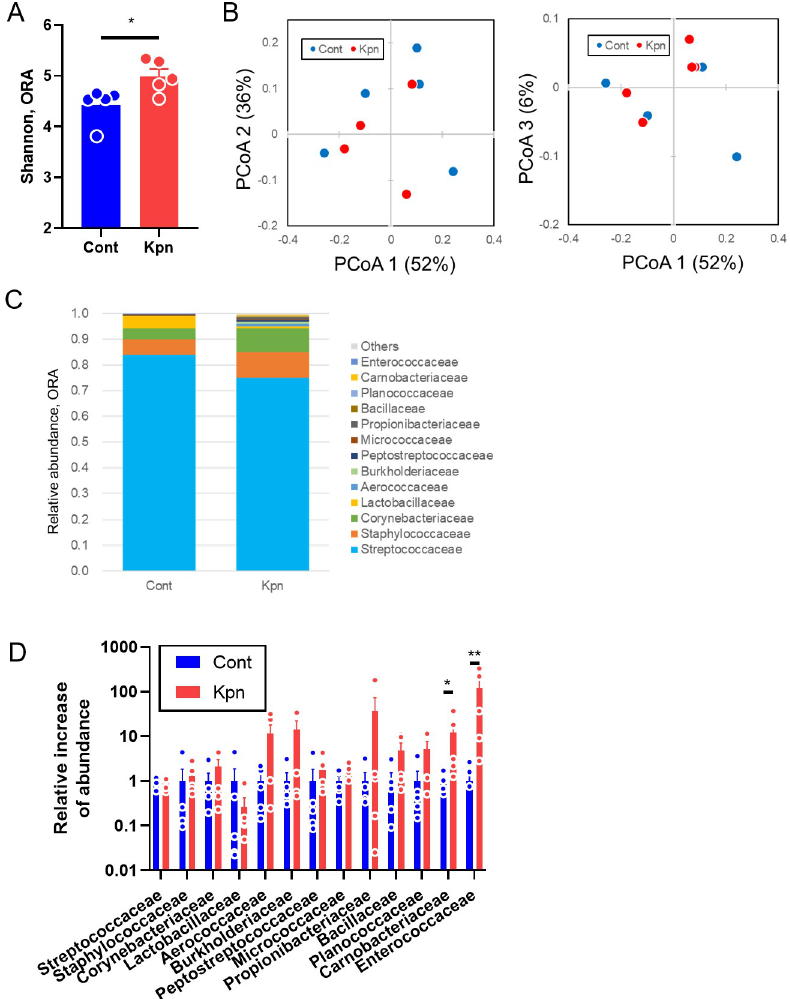
Fig 3. Oral microbiota after K . pneumoniae infection. (A) Shannon index of oral swabs (ORA). (B) Weighted UniFrac with three principal coordinate components. The number in parenthesis represents the contribution of each component. (C) Taxonomic distribution at the family level. Only families with 0.1% or more abundance in at least one group are presented. (D) Relative change in abundance during pneumonia, compared to the case in control mice. Only families with 0.1% or more abundance in both groups are presented. Data represent two independent experiments. Five mice were used for each group. Filled circles represent individual mice, and each bar represents the mean ± SEM. PCoA, principal coordinate analysis. �� , p < 0.01. � , p < 0.05. NS, not